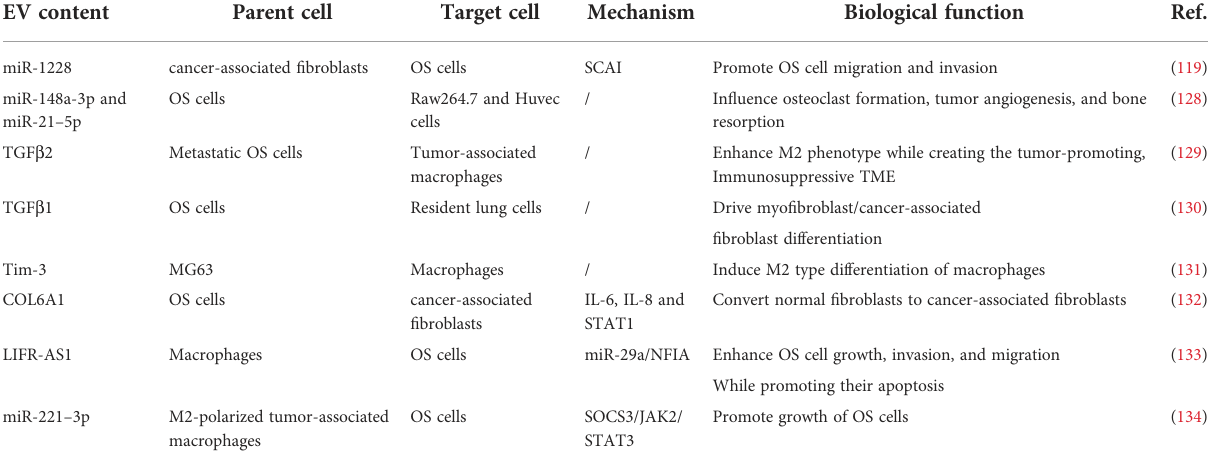
TABLE 4 The biological functions of exosome in the immuno-modulation of